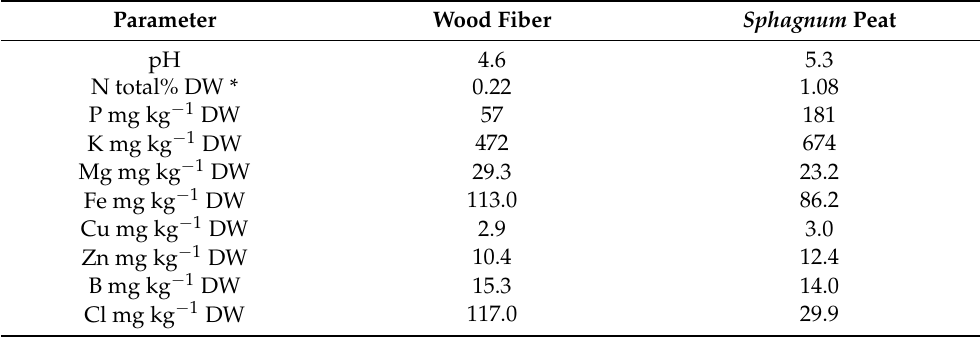
Table 3. Characteristics of wood fiber and Sphagnum peat used in the experiment as growing media. Parameter Wood Fiber Sphagnum Peat